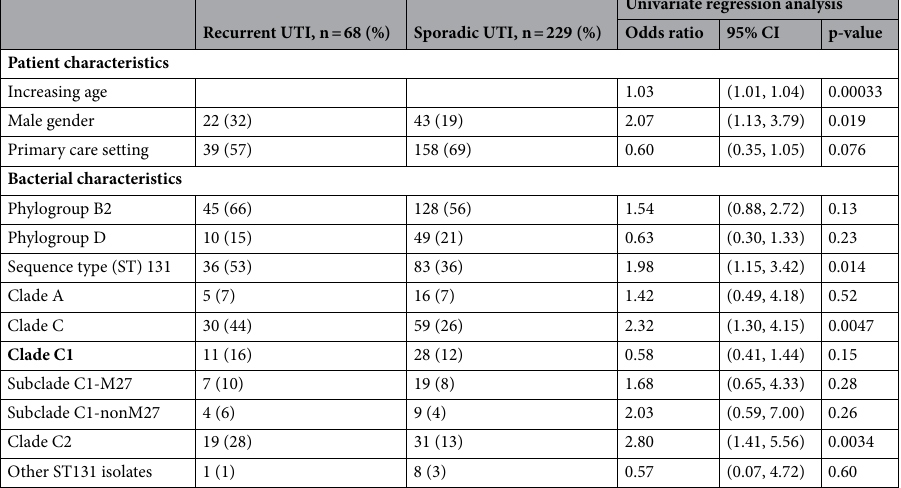
Recurrent UTI, n = 68 (%) Sporadic UTI, n = 229 (%)